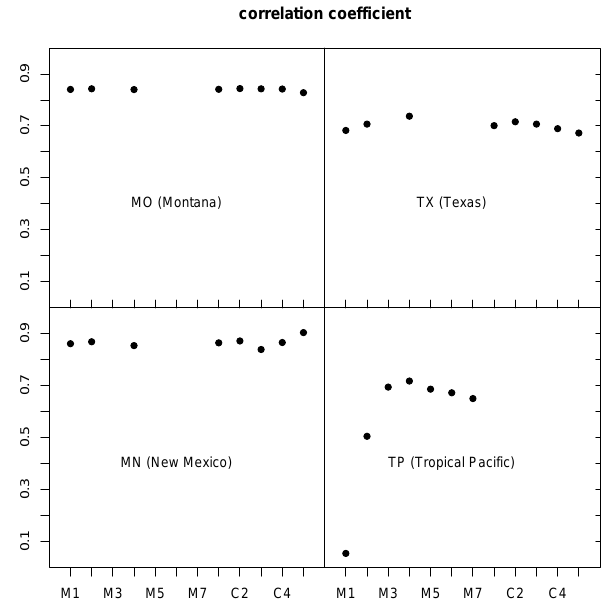
Fig. 8. Summary of the correlation between the melting rate and the precipitation rate for the mid-CAPE cases. For MO and NM clouds, the correlation is 2min time-lagged; for TX clouds, it is 3min; and for TP clouds, it is not time-lagged. Fig. 7. (a) The sum of drop mass (gkg − 1 in dash-dotted lines), graupel mass (gkg − 1 in solid lines) at the level just above 0 ◦ C. The precipitation rate in Fig. 4 is also added in the figure for reference. Note that the precipitation rate is multiplied by − 0.1 to avoid con- gestion in the figure. Temporal variation of total riming rate (b) and total melting rate (c) from MO-v2 cases. The units are gkg − 1 s − 1 .